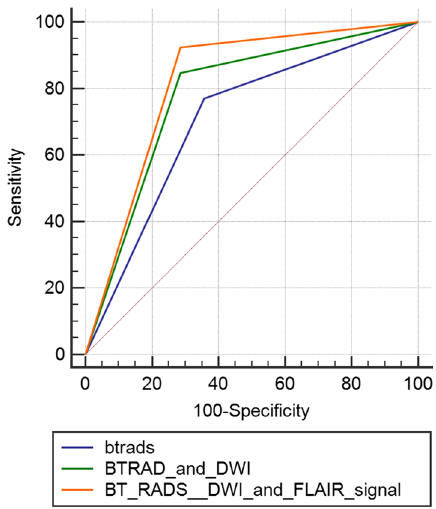
Fig. 2 Comparison of The ROC curves regarding the AUC for BT-RADS, BT-RADS added DWI, and BT-RADS added DWI and FLAIR signal alteration within the resection cavity. ROC receiver operating = characteristic curve; BT-RADS brain tumor reporting and data = system; AUC area under curve; DWI diffusion-weighted image; = = FLAIR